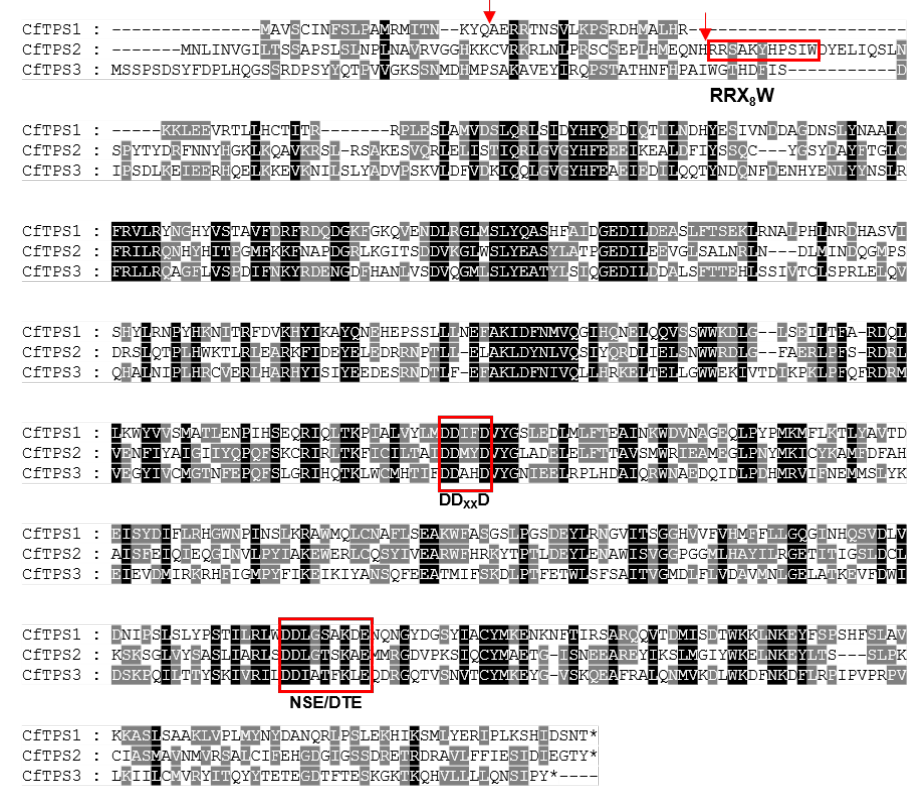
Figure 4. Alignment of the amino acid sequences of CfTPS1 , CfTPS2 , and CfTPS3 . Amino acids identical in all three proteins are shaded in black and those identical in two proteins are shaded in gray. The three highly conserved motifs are labeled RR-(x)8-W, DDxxD, and (N,D)Dxx(S,T)xxxE, respectively. Arrows indicate putative cleavage sites of transit peptides.